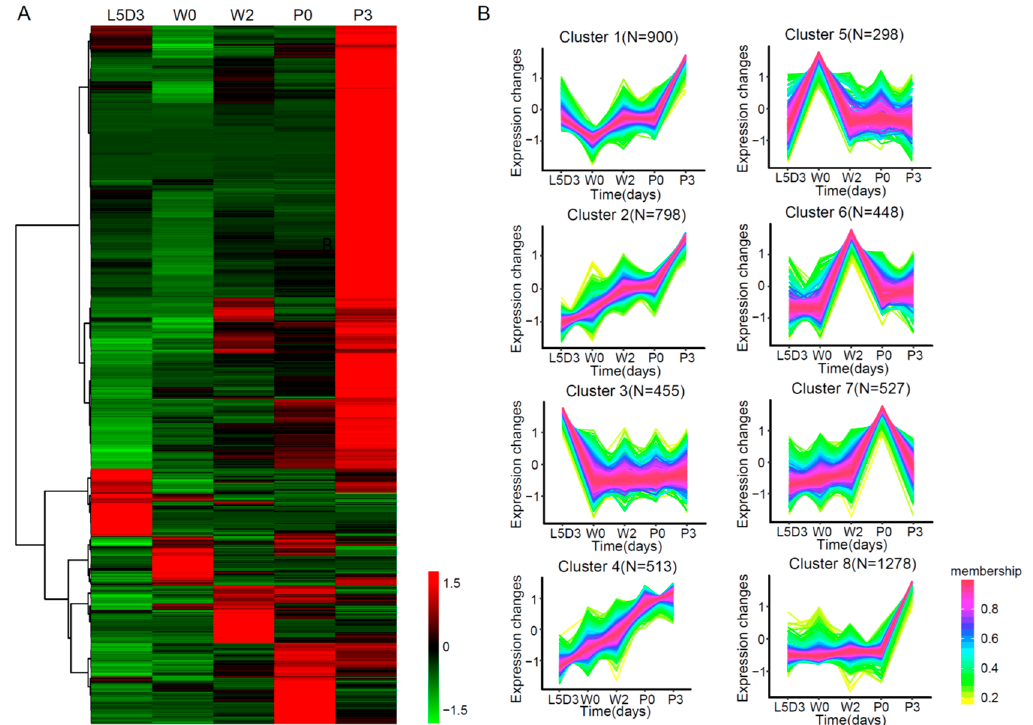
Figure 4. Clustering analysis of all DEGs in the silkworm fat body. ( A ) Hierarchical clustering of all DEGs. Red, genes with high expression levels; Green, gene with low expression levels. ( B ) Co-expression analysis of all DEGs. The digits denote the number of genes in each cluster. The DEGs in each cluster are listed in Table S3. Red, the high correlation between genes; yellow, the low correlation between genes.